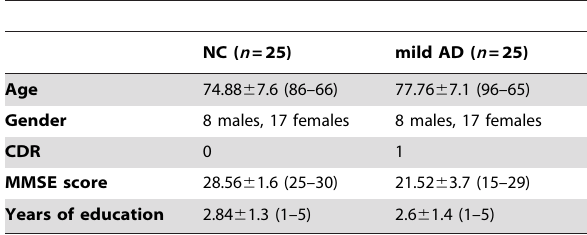
Table 1. Demographic characteristics of normal controls and subjects with Alzheimer’s